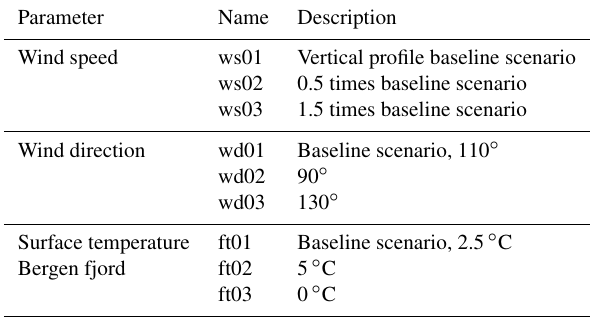
Table 2. Parameters for the different meteorological scenarios ∗